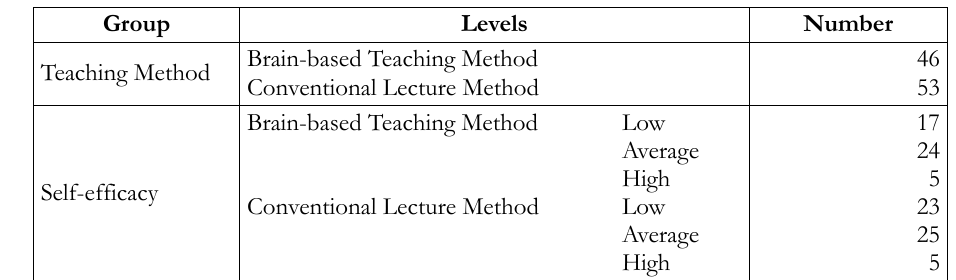
Table 1. Demographic representation of participants